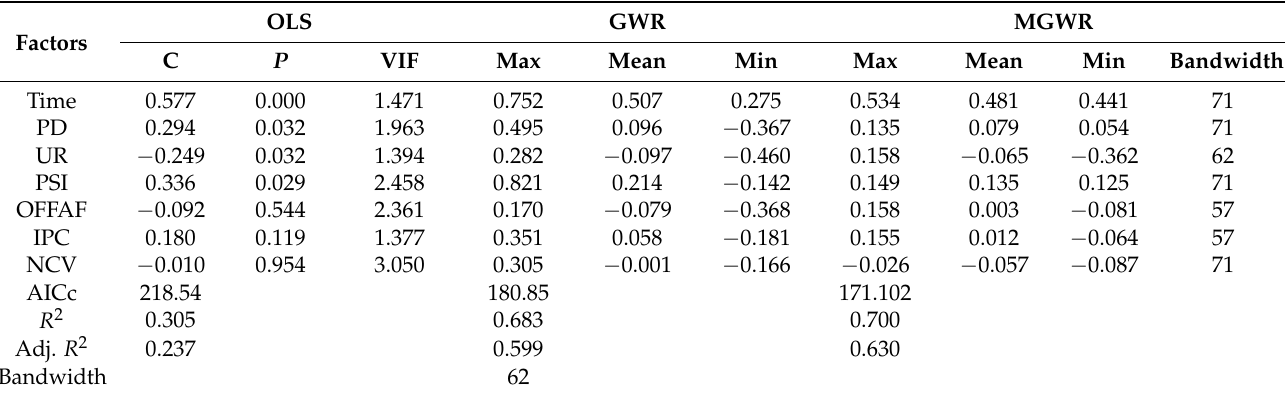
Table 1. Regression results of the ordinary least squares (OLS) model, the geographically weighted regression (GWR) model, and the multiscale geographically weighted regression (MGWR) model. C is coefficient; Max is maximum value of coefficient; Mean is average value of coefficient; Min is minimum value of coefficient; AICc (Akaike information criterion) is a correction for small sample sizes, the smaller the value, the higher the goodness of